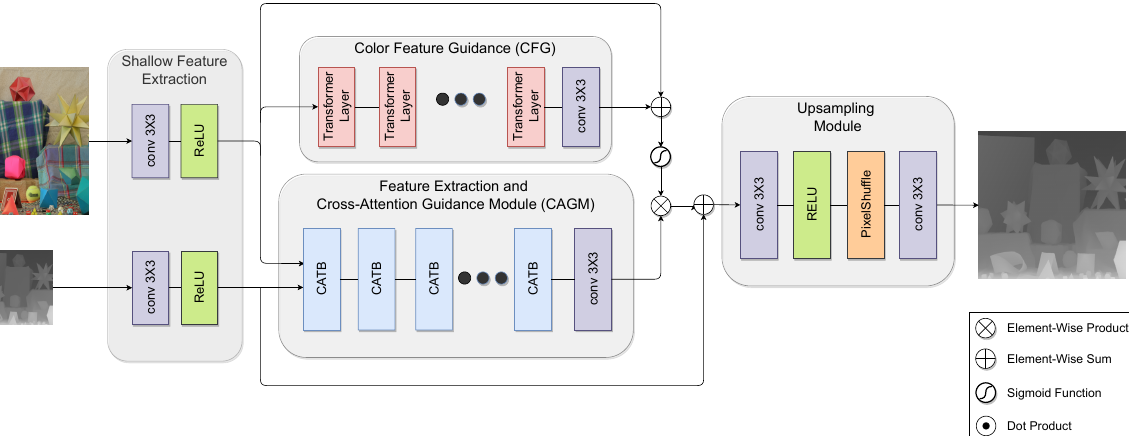
Figure 1. The proposed FCTN architecture for guided depth SR with a 2 × upsampling